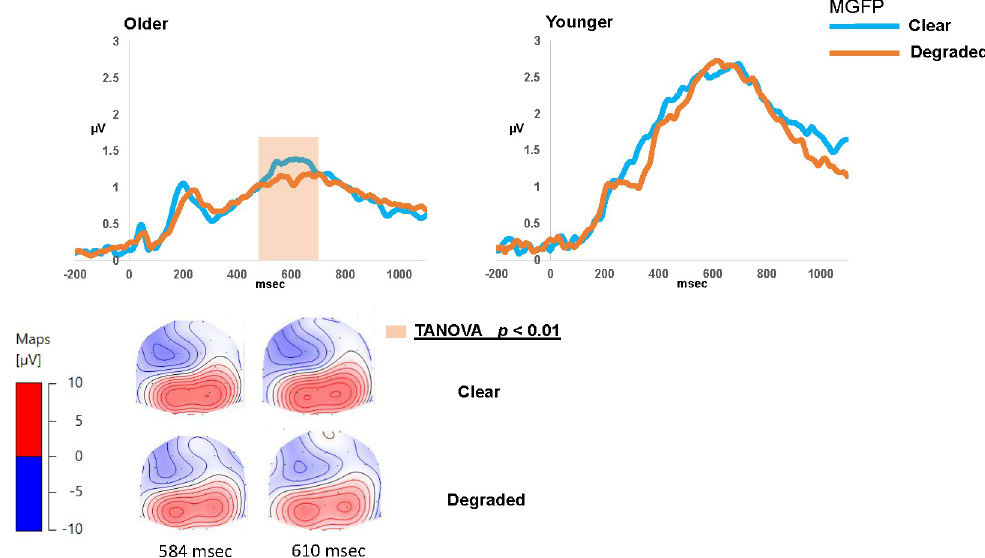
Fig 6. Topographical comparison of the target stimulus processing (epoch = 100–800 msec) for the older and younger participants: Top panel shows the grand-averaged mean global field power (MGFP) waveforms for the clear and degraded listening conditions in each group. Timeframes in the shaded region indicates periods of statistically significant differences ( p < 0.01) between listening conditions. Bottom panel shows the corresponding topographical maps that are linked to the shaded timeframes of the MGFP for each listening